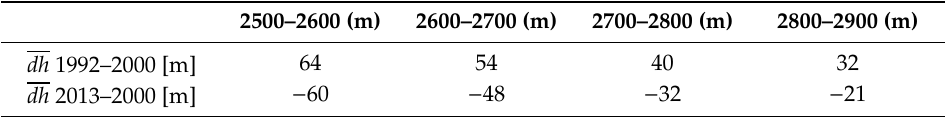
Figure 10. ( a ) Surface elevation for the lower part of HEF as shown in the image. ( b ) Elevation values are derived from three DEMs for a manually digitized centre line. Table 5. Mean elevation di ff erences for the listed elevation intervals for HEF from the DEM 1992, the SRTM DEM (2000) and the TanDEM-X DEM